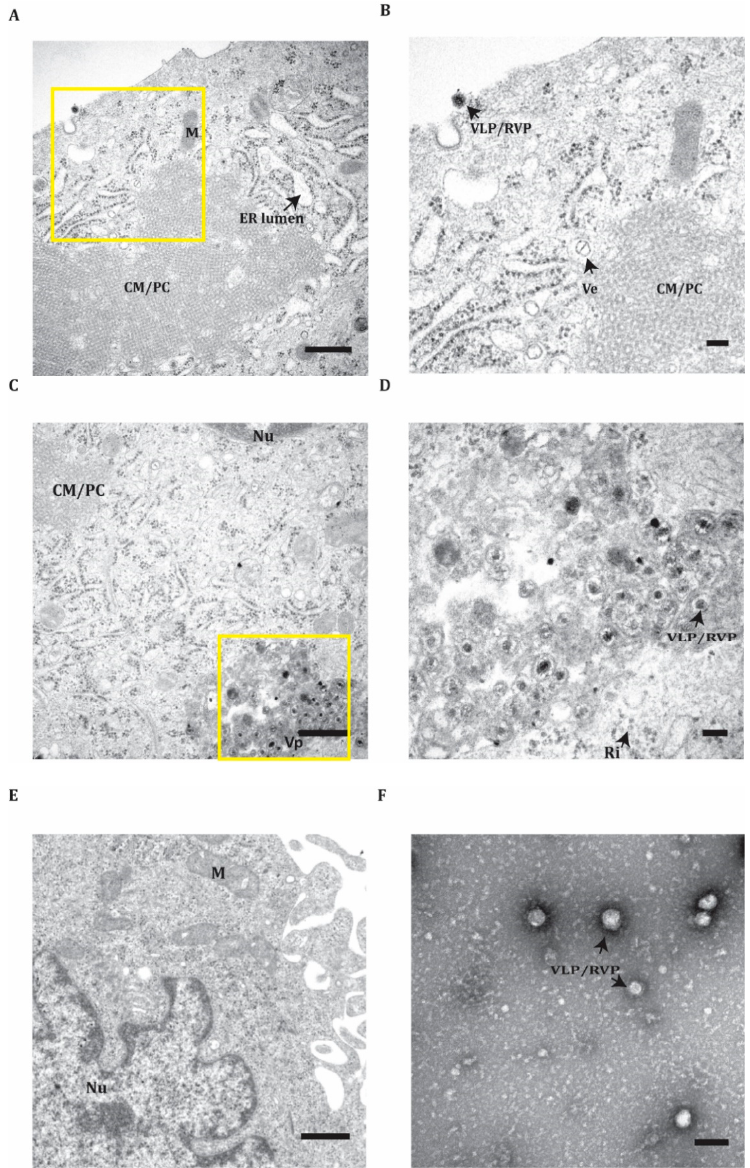
Figure 3. Transmission electron microscopy images of the RVP production system. ( A – D ) Images representing the C-prM-E stable BHK-21 cell line transfected with the KUNV replicon construct. ( A , C ) represent di ff erent subcellular areas, whereas ( B , D ) show higher magnification images of the yellow boxes indicated in the ( A ) and the ( C ), respectively. ( E ) The image represents BHK-21 cells used as control. ( F ) The image of cell culture supernatants from the C-prM-E stable cells transfected with the KUNV replicon. ER: the endoplasmic reticulum; Nu: nucleus; M: mitochondria; CM / PC: convoluted membranes, paracrystalline structure; Vp: vesicle packets; Ve: virus-induced vesicles in the ER; VLP / RVP: virus-like particle, reporter virus-like particles; Ri: ribosome. Scale bars represent 500 nm in ( A , C , E ) and 100 nm in ( B , D , F